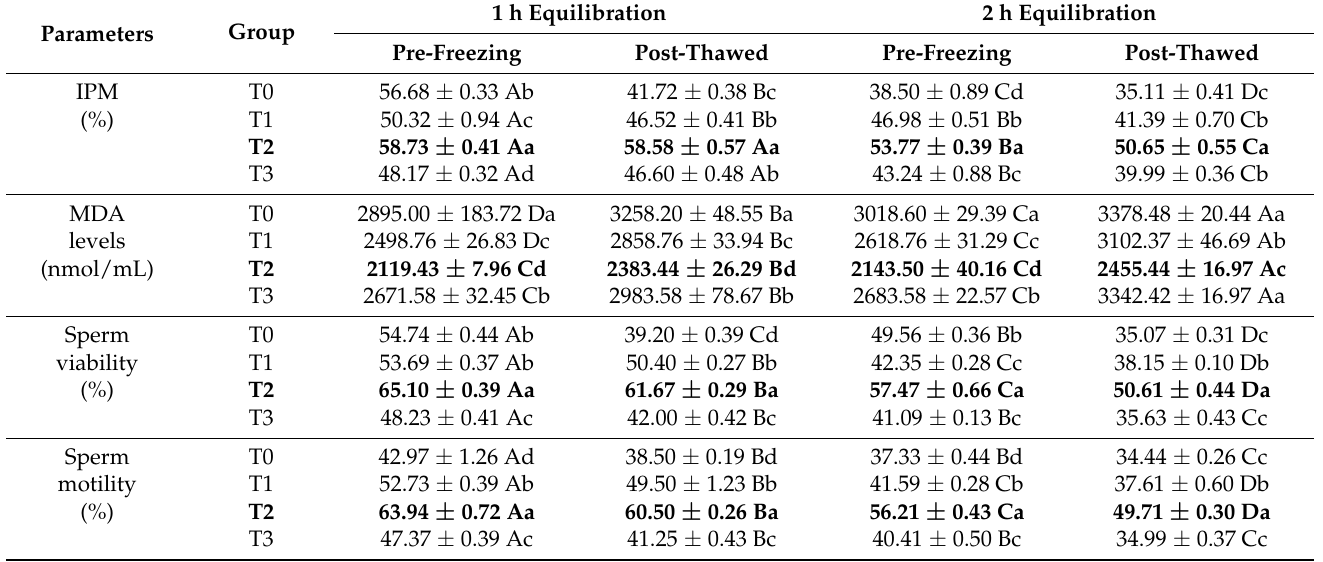
Table 2. Effect of green tea extract (GTE) in skim milk–egg yolk (SM-EY) extender on IPM, MDA levels, sperm viability, motility, and SDF of extended semen equilibrated for 1 or 2 h pre-freezing or post-thawed in Kacang buck